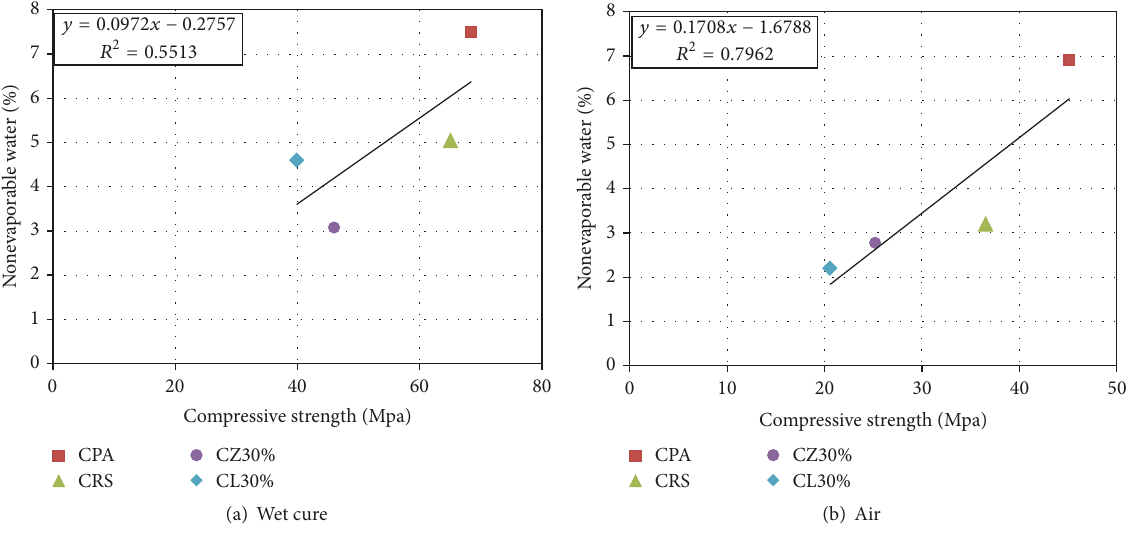
Figure 18: Nonevaporable water as a function of compressive